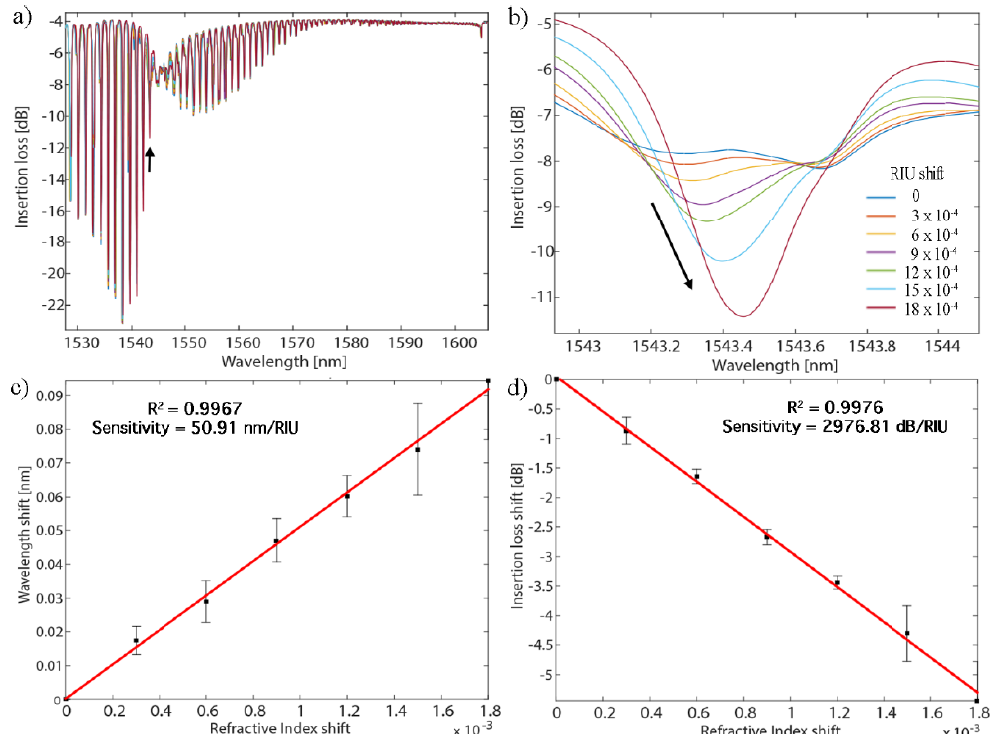
Figure 5. ( a ) P-polarized spectral evolution of a hybrid gold-coated TFBG configuration immersed in different LiCl solutions. ( b ) Zoom on the most sensitive mode. ( c ) Wavelength evolution of that mode as function of RI change ( d ) Amplitude evolution of that mode as function of refractive index (RI) change for three tested fibers.